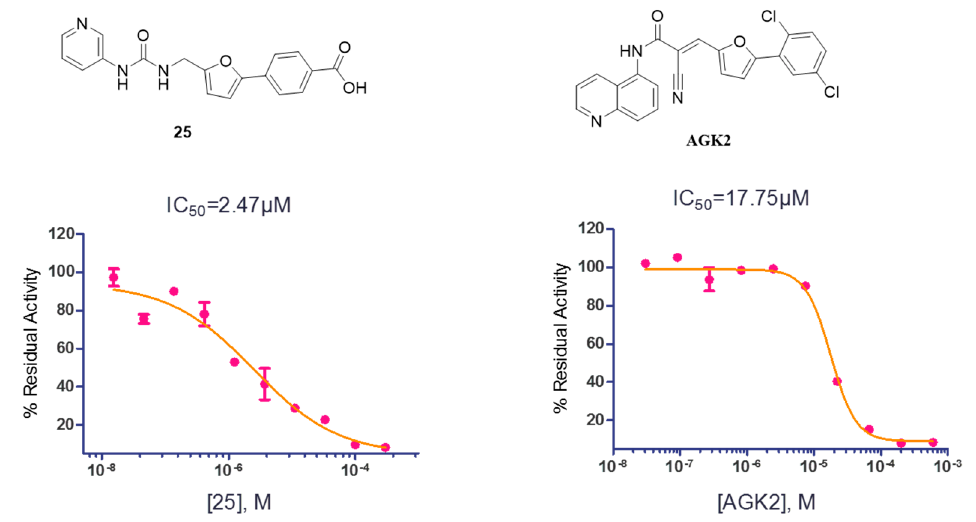
Figure 3. The chemical structures and IC 50 curves against SIRT2 of 25 and AGK2. Molecules 2019 , 24 , x FOR PEER REVIEW